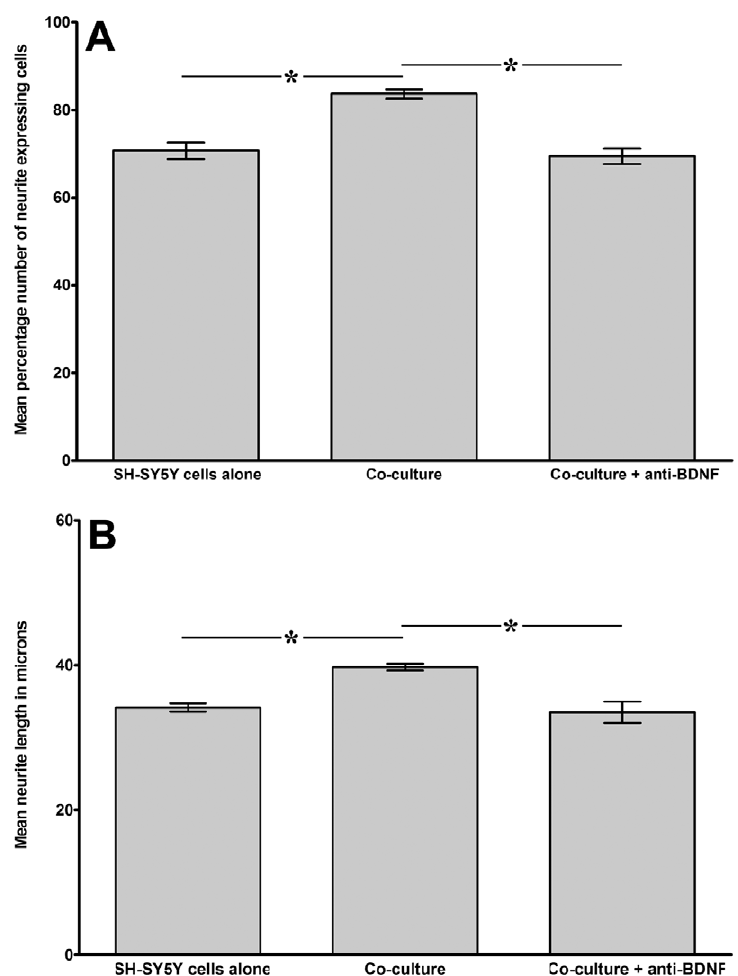
Figure 5. Analysis of neural cell behaviour following co-culture with degenerate human NP cells with or without addition of anti- BDNF antibody. Histograms illustrating the percentage number of neurite expressing cells (A) and mean neurite length (B) from differentiated SH- SY5Y cells co-cultured with degenerate NP cells without contact for 48 hours with or without addition of anti-BDNF antibody (n=4; * =P , 0.05).